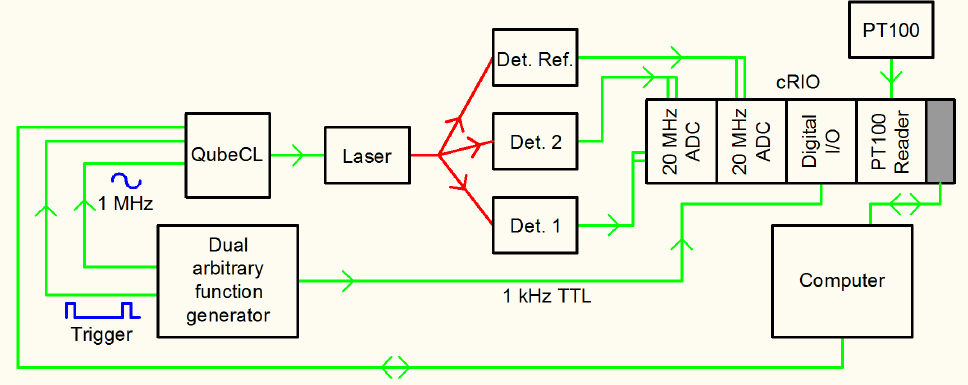
Figure 5. Block diagram of the